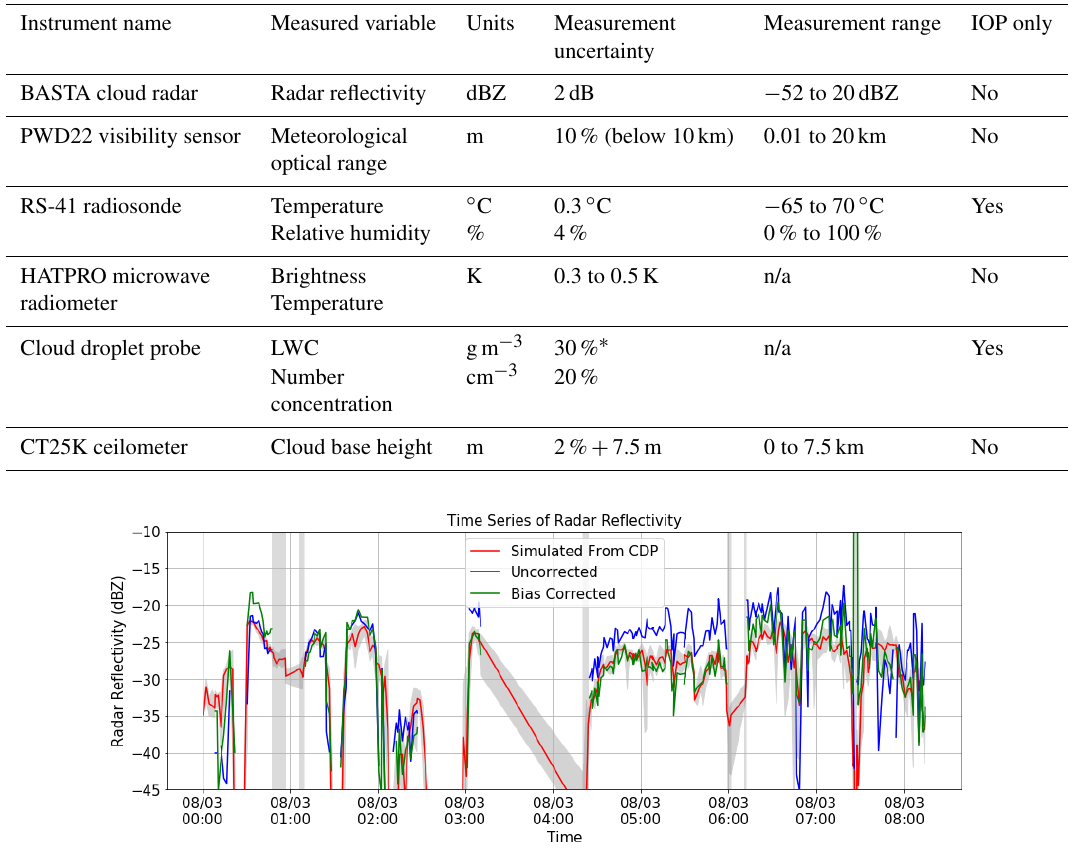
Table 4. Table of instruments that were deployed during the SOFOG-3D field campaign that were used in this study. ∗ The measurement uncertainty is not well defined and may change as a function of the droplet sizes and diameters. n/a: not applicable.